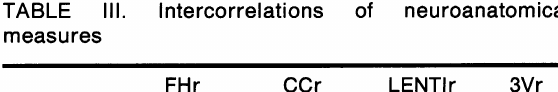
TABLE III. Intercorrelations of neuroanatomical measures (± 1.48 mm) using the method described in Bland and Altman (1986). FHr CCr LENTlr 3Vr FHr 0.56 Neurological measures -0.53 Comparison of measures of neurological LENTlr 0.001 0.001 -0.76 0.001 Values on top right diagonal represent correlations of measures for the "early" and "late" HO groups (n = 20). Values at bottom left represent level of statistical probabil ity of correlation.